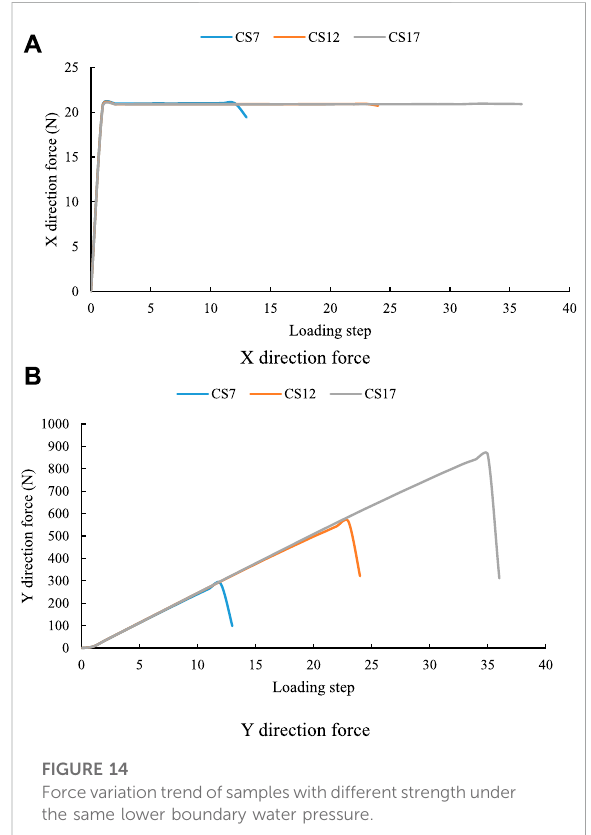
FIGURE 14 Forcevariationtrendofsampleswithdifferentstrengthunder the same lower boundary water pressure.